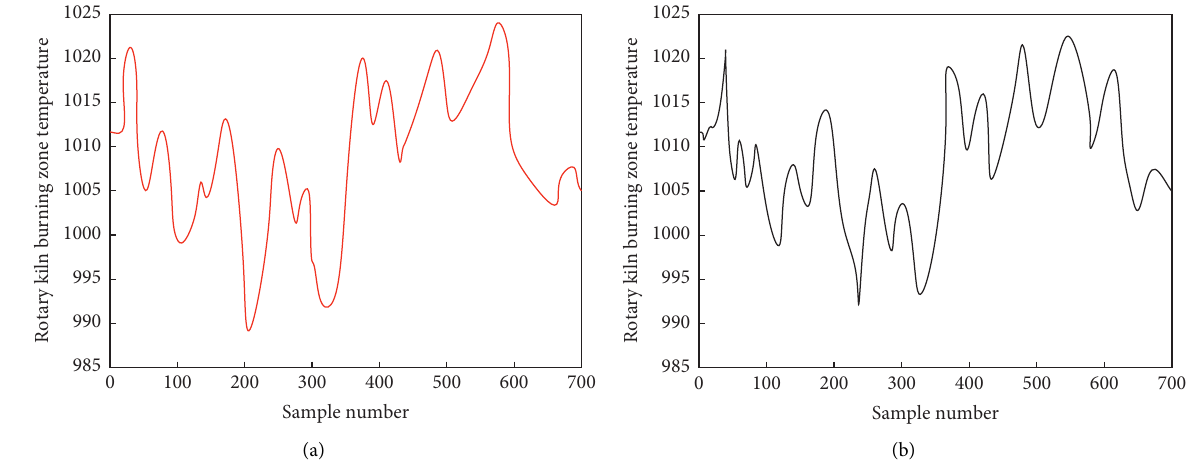
Figure 8: Online temperature prediction results. (a) True value. (b) Online LSSVM predicted value.